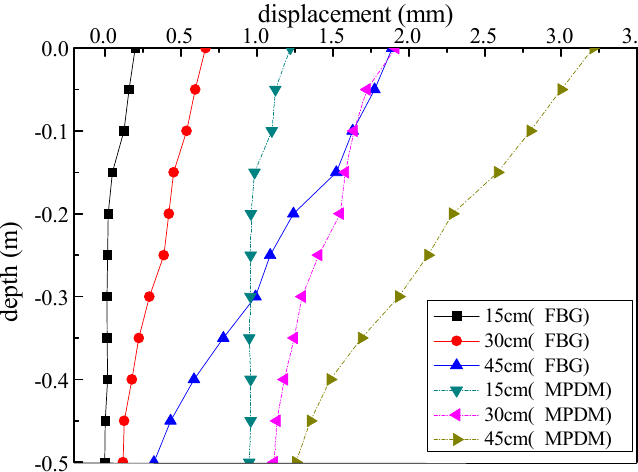
Figure 10. Photo of the test model.